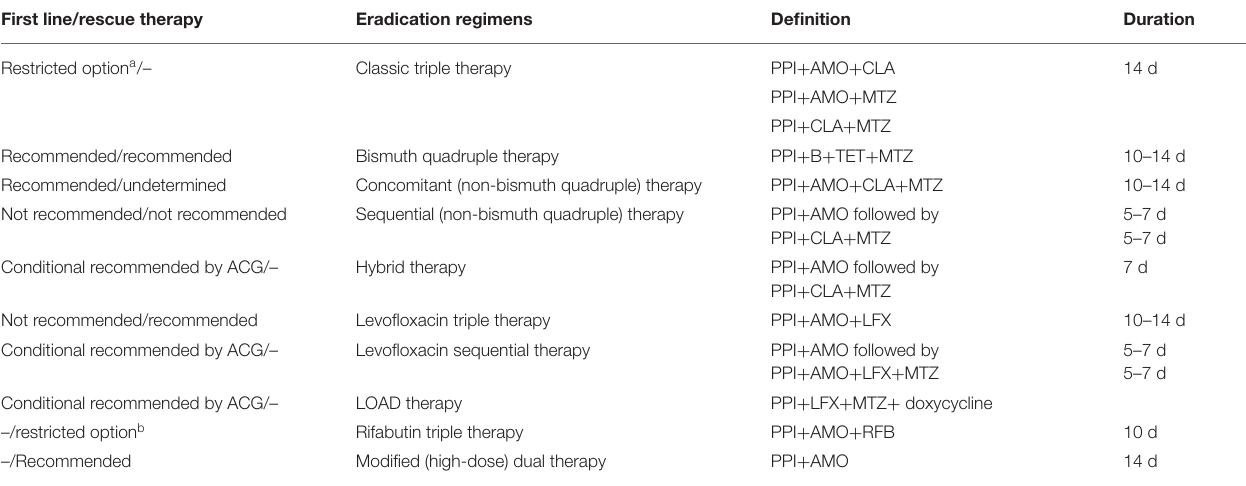
TABLE 1 | Current mainstream